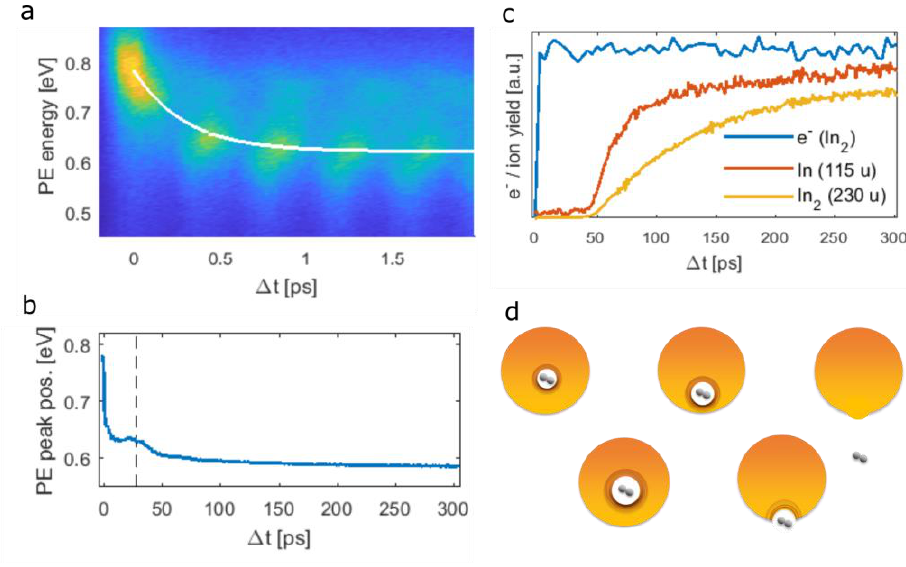
Figure 1: Time evolution of the In 2 -He N system after photoexcitation. (a) PE spectrum within the first 2 ps. The white line connects the signal maxima. (b) PE peak position up to 300 ps, as determined by Gaussian fits to the corresponding PE spectra. The dashed line at 28 ps indicates the maximum of the temporal increase in PE energy. (c) Ion yields recorded at the In monomer/dimer masses of 115/230 u for photoexcitation at the monomer/dimer band at 376/345 nm (red/yellow line) and total PE yield integrated over all kinetic energies for excitation at 345 nm (blue line). (d) Sketch of the In 2 ejection